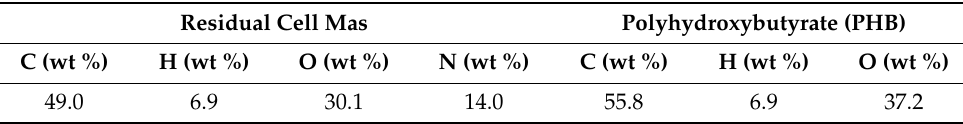
Table 4. Elemental composition of residual cell mass and PHB of C. necator (ash free, dry base) a . Residual Cell Mas